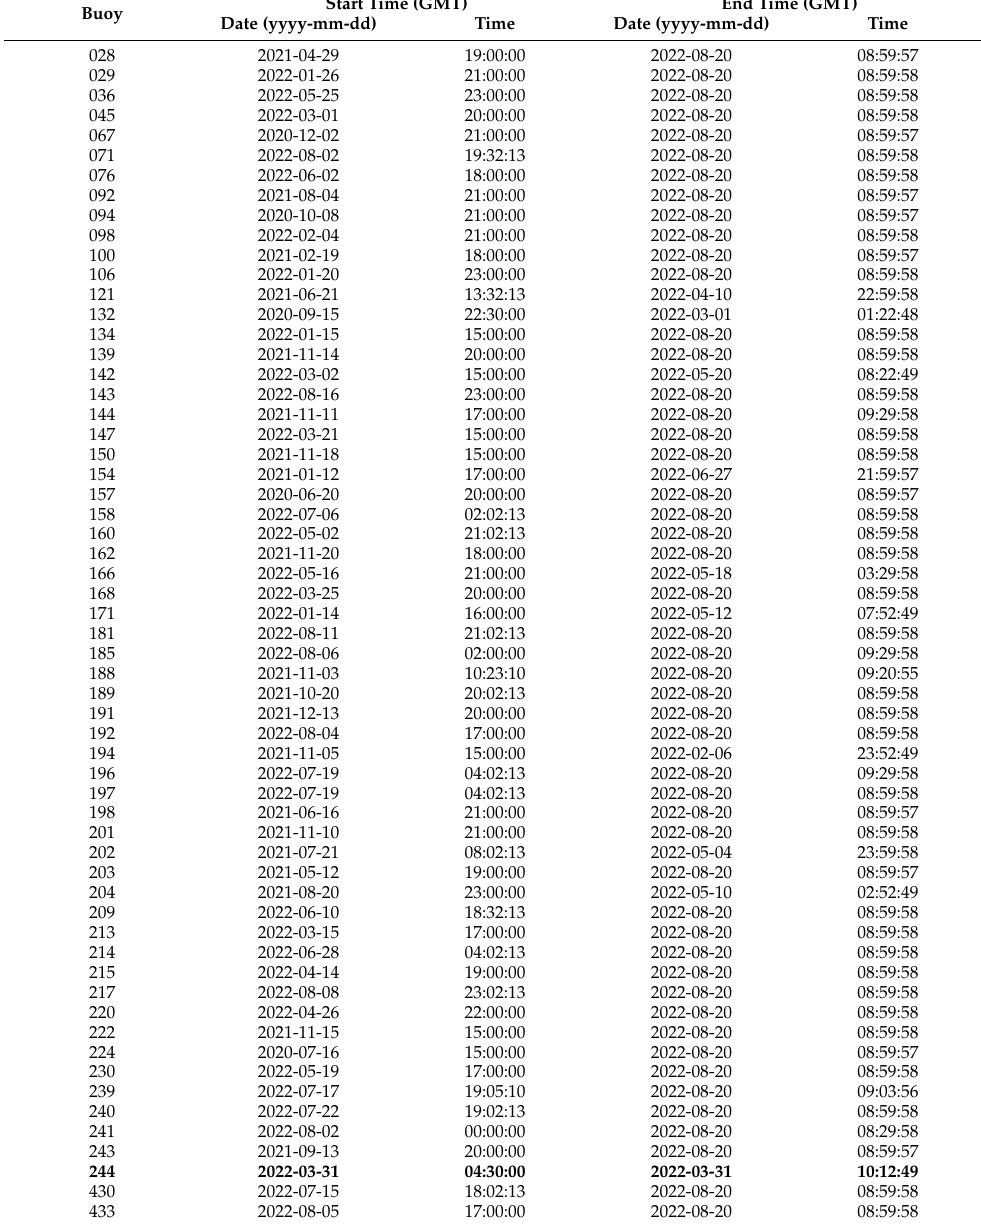
Table A1. Start and end times for which the measurements have been recorded by each of the 59 buoys. These are GMT times which are reported in the format year-month-day and hours-minutes-seconds. In bold, the buoy whose measurements have been recorded for a smaller period of